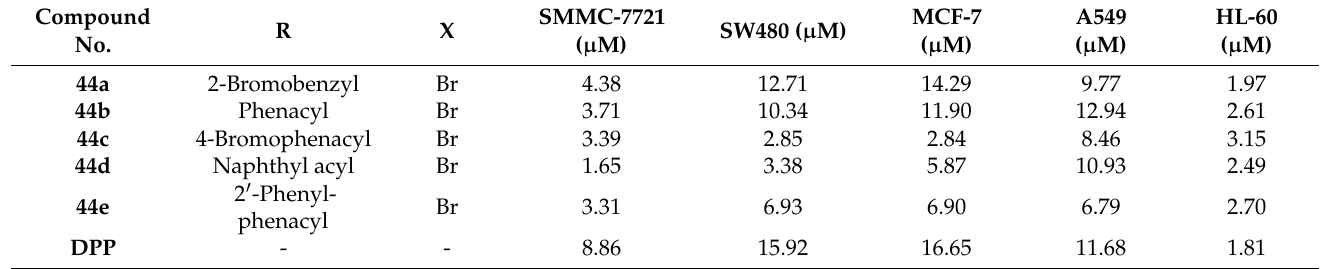
Figure 50. Structure of imidazole-based benzofuran hybrid derivatives ( 44 ). Table 37. In vitro cytotoxic activities of imidazole based benzofuran hybrid compounds 44 ( a – e ).